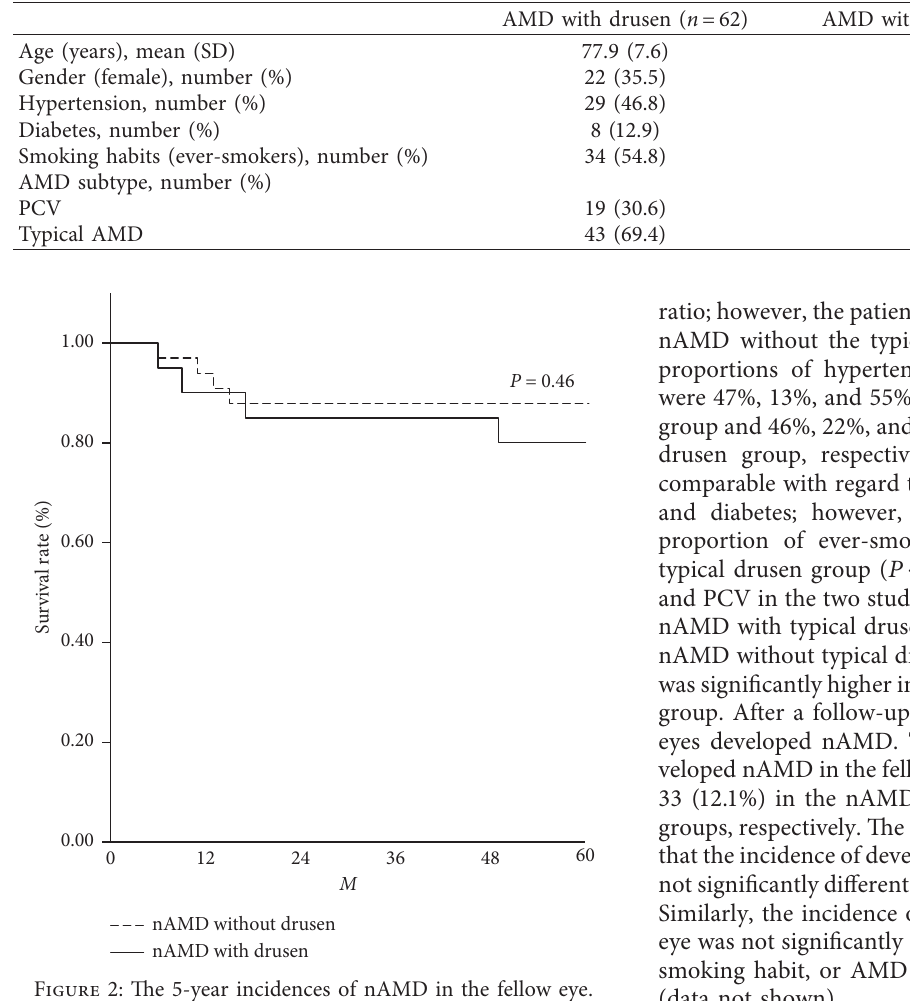
Figure 1: Fundus color photograph and OCT of soft drusen, SDDs, and pachydrusen. Table 1: Clinical characteristics of nAMD patients.